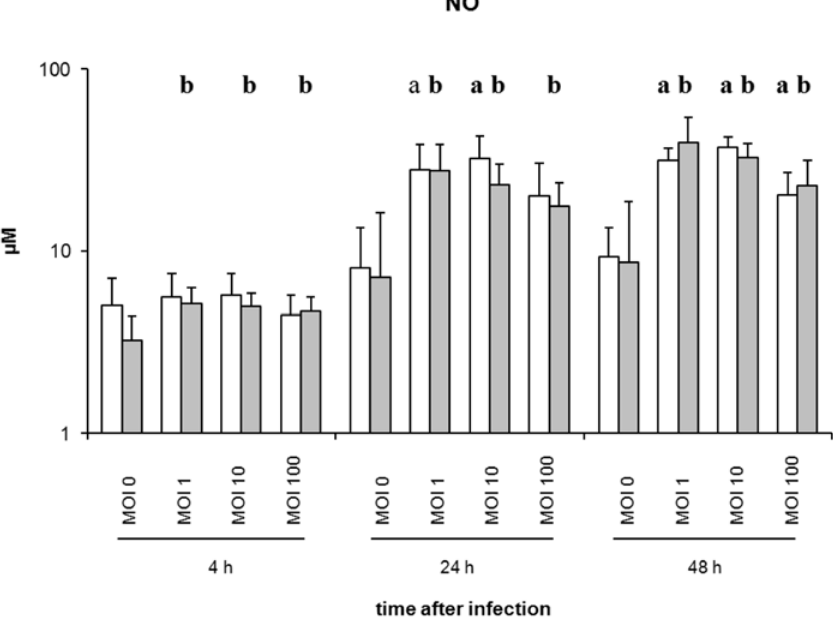
Fig 6. Detection of nitric oxide concentration in supernatants from avian macrophages after Salmonella infection. White columns — macrophages infected with S . Typhimurium (n = 4), Grey columns — macrophages infected with S . Infantis (n = 6) a ) P (cid:2) 0.05 or a) P (cid:2) 0.1 S . Typhimurium vs. control; b ) P (cid:2) 0.05 or b) P (cid:2) 0.1 S . Infantis vs.